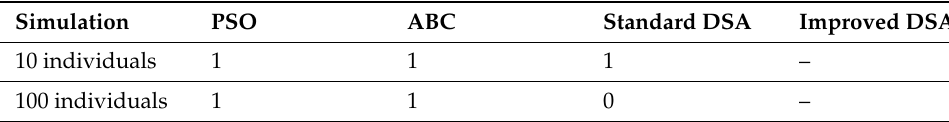
Table 4. Results of Wilcoxon’s tests of the four